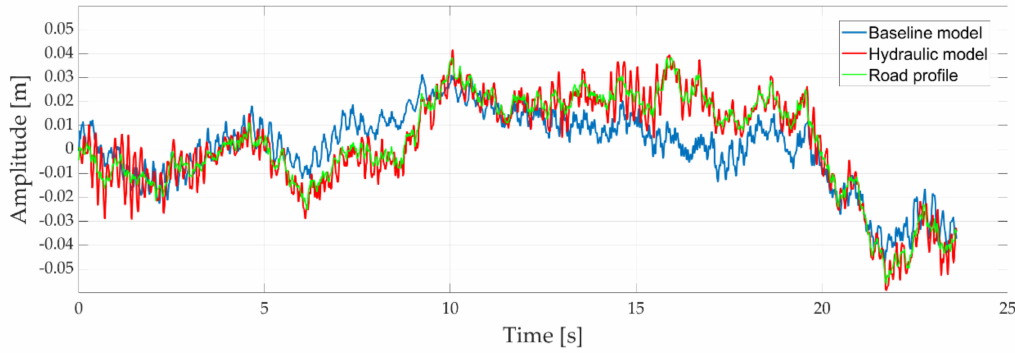
Figure 15. Front left wheel absolute vertical motion over a realistic road